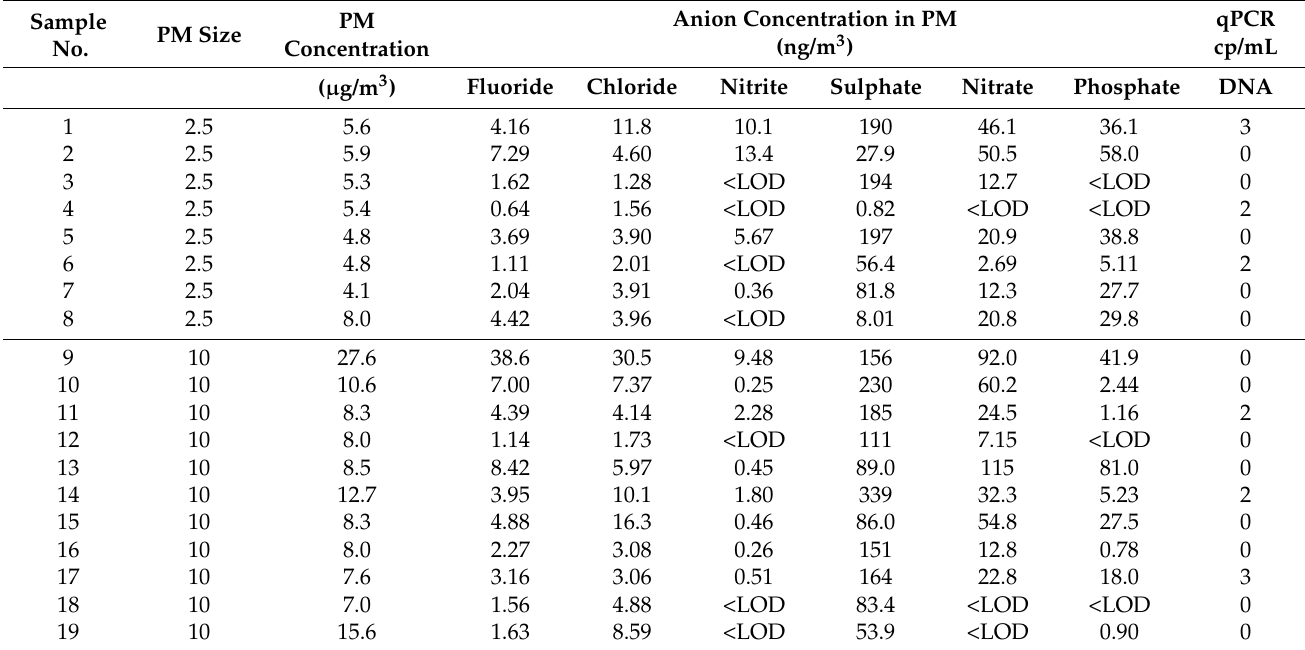
Table interpretation. qPCR = quantitative PCR test; cp/mL DNA = number of copies per mL of mycobacterial DNA; LOD = limit od detection; qPCR values are on a logarithmic scale. LOD of nitrite, nitrate and phosphate is 0.19, 0.17 and 0.26 ng/m 3 , respectively.